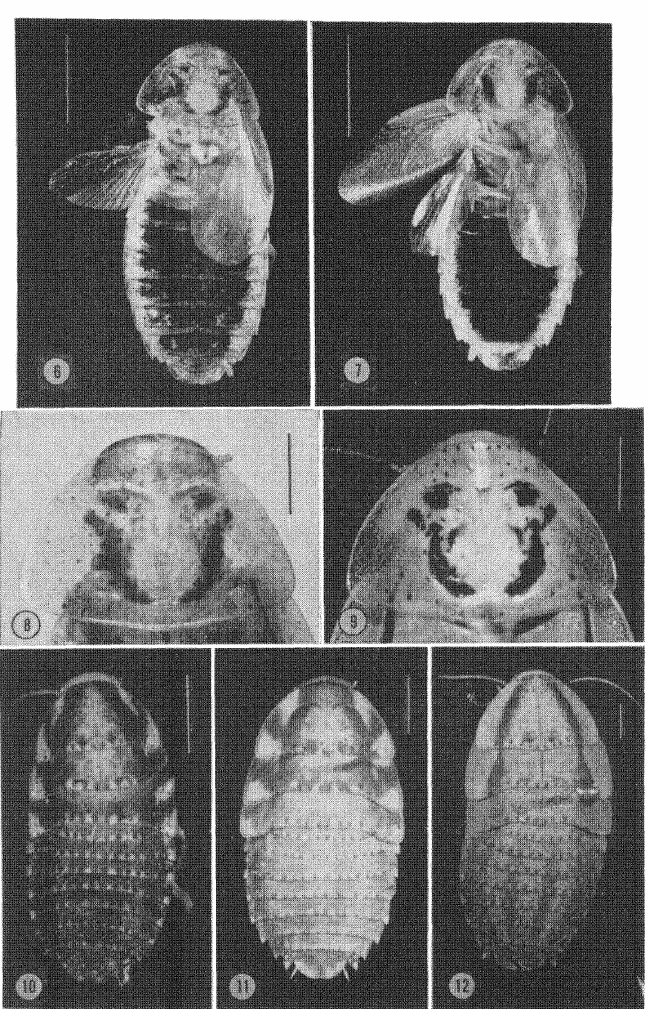
Figs. 6-12. Pinaconota bifasciatia. 6. Brachypterous female. 7. Bra- ehypterous male. 8. Pronotum of female shown in fig. 6. (both 6 and from Ilha das Aleatrazes, S. Paulo, Brazil.) 9. Pronotum of maeropterous taken at quarantine on a plane in Miami, Florida (with bromeliads), Jan. 20, 1972. 10-12. Three nymphs: 10 and 12. From Brazil, in plane at San Francisco, Nov. 17, 1970 (with bromeliads). 11. From Brazil, at Hoboken, Oct. 30, 1940 (with orchids). (scale: figs. 6-7 5 ram; figs. 8-12 "-- 2